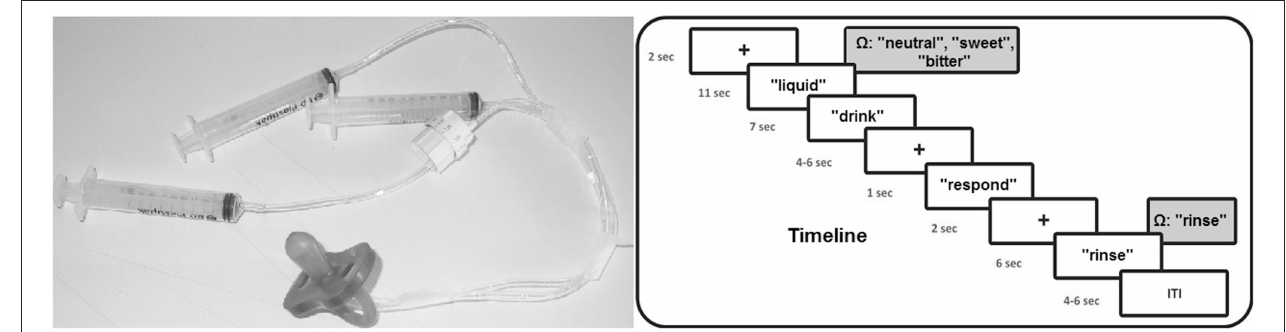
FIGURE 1 | Timeline of the experimental procedure and picture of the used materials for the liquid administration. (cid:127) represents the auditory cue received by the